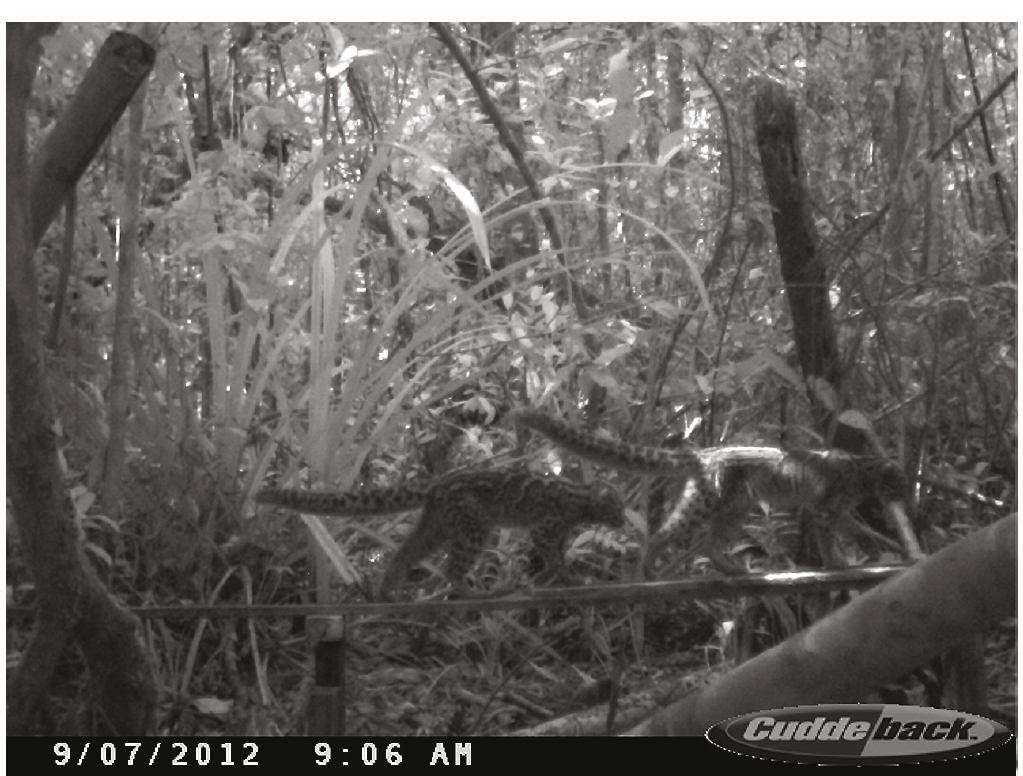
Image 5. Marbled Cat Pardofelis marmorata and